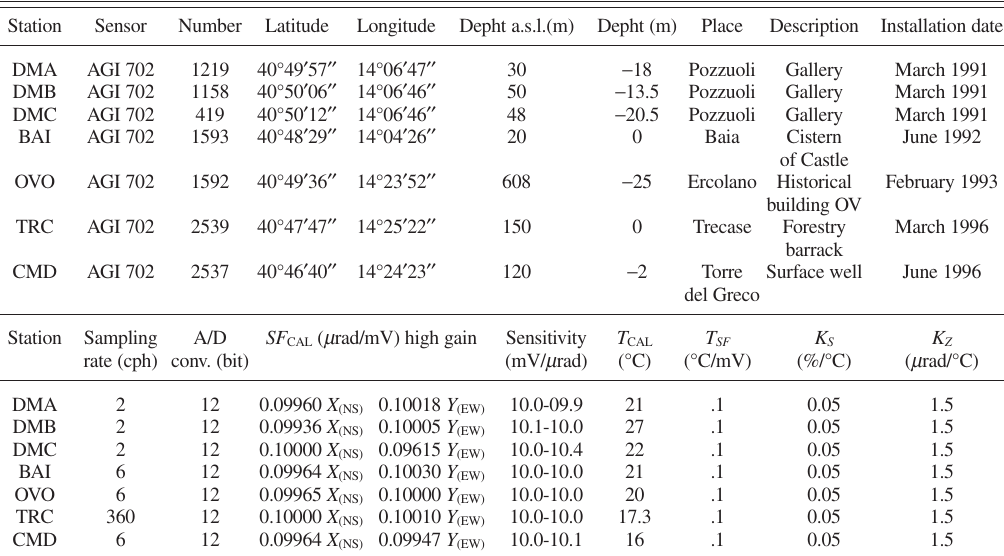
Table I. OV tilt network: description and technical features.